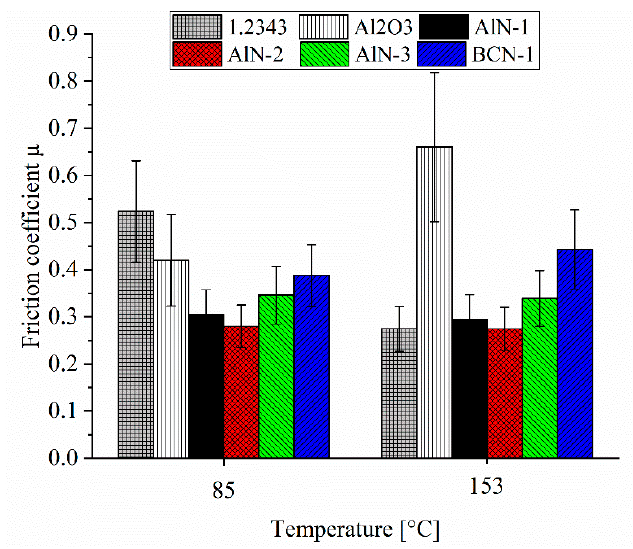
Figure 4. Friction coefficient of the AlN-1, AlN-2, AlN-3, and BCN-1 thin films, as well as the steel substrate and the Al 2 O 3 coating, at 85 and 153 °C using PP counter balls.